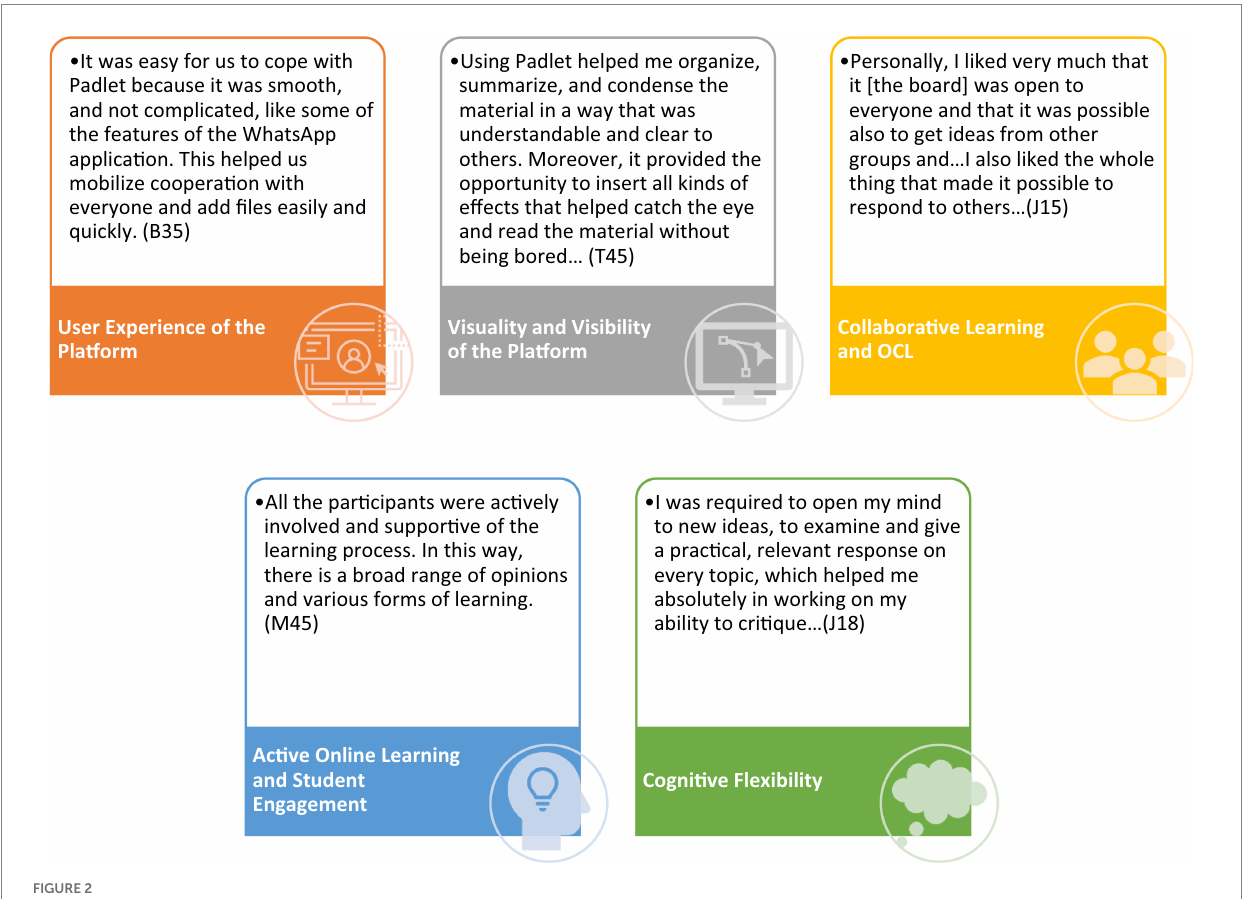
FIGURE 2 Derived categories and exemplary quotes from the